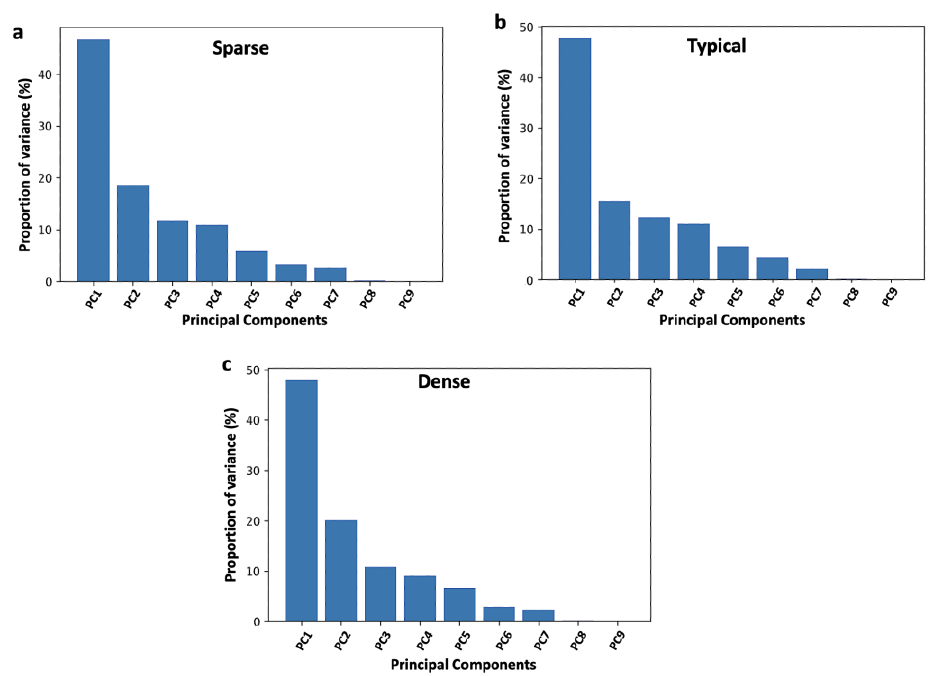
Figure A1. Scree plot to select the number of principal components (PC) in the case of simulated datasets: sparse ( a ), typical ( b ), and dense ( c ).